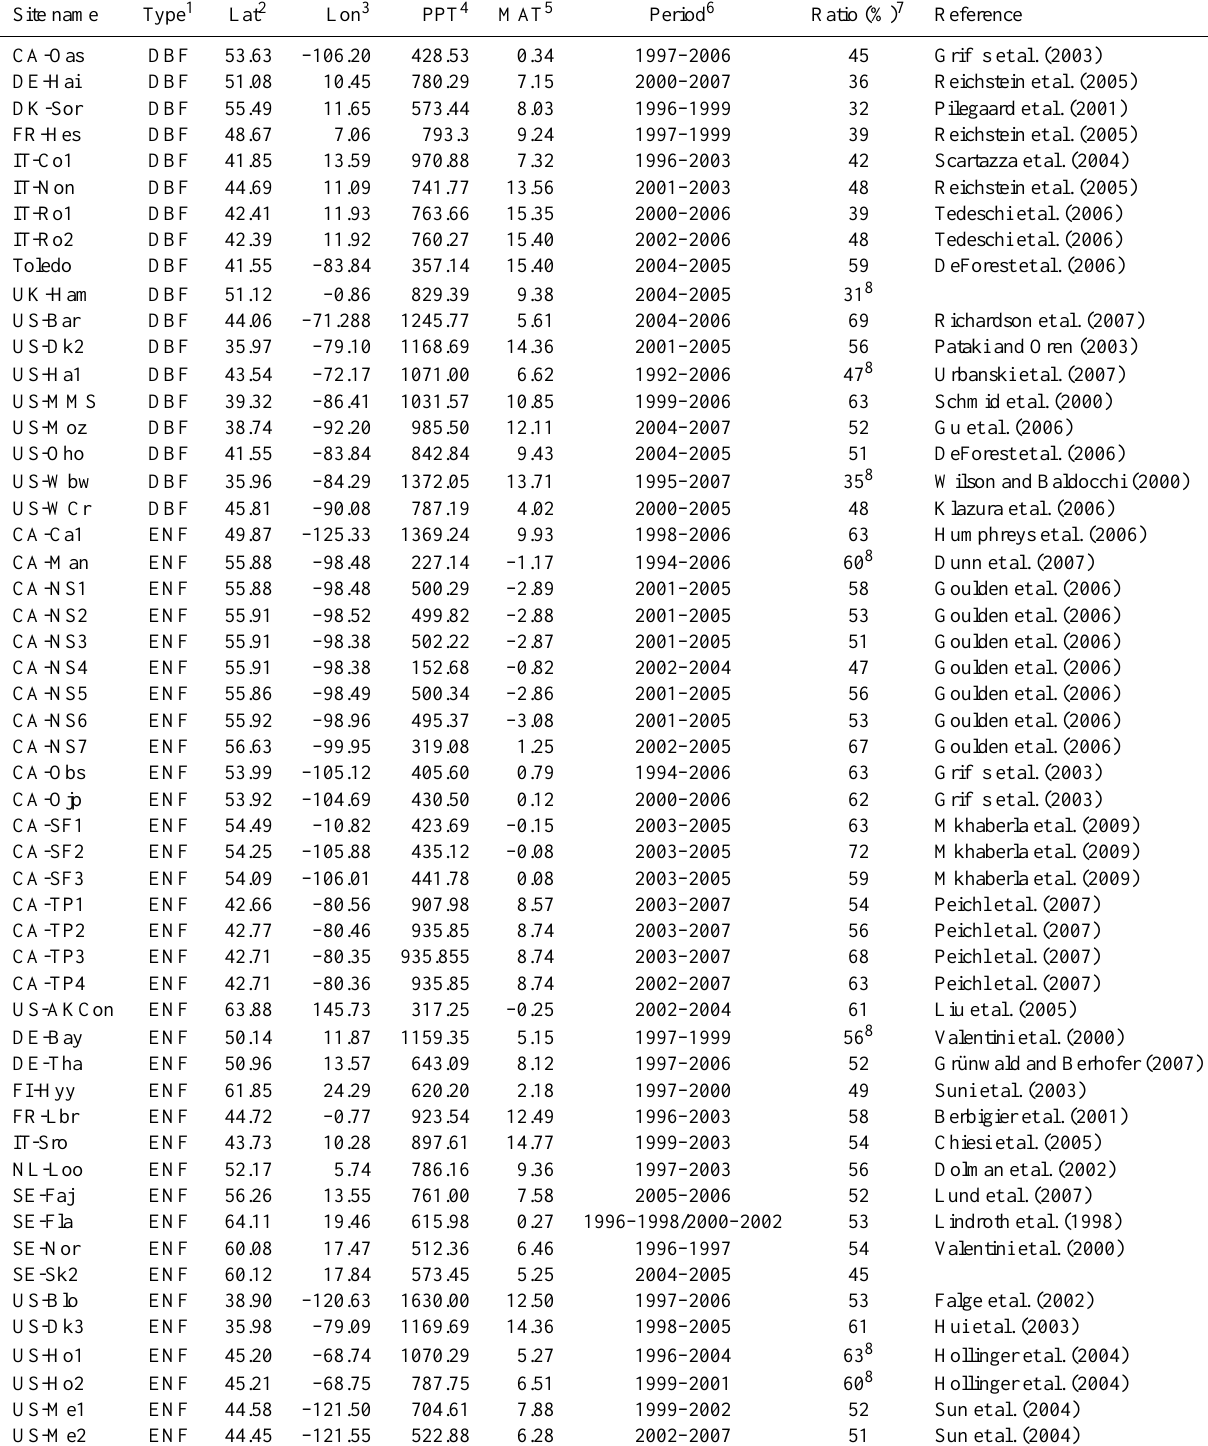
Table 1. The FLUXNET sites used in this study arranged according to ecosystem